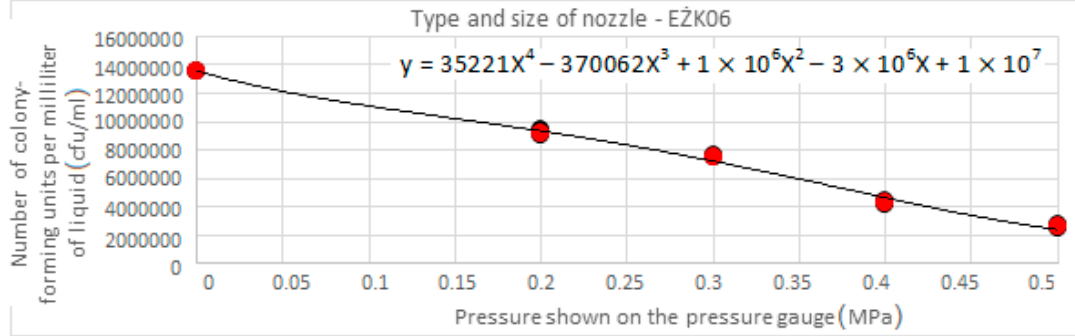
Figure 6. The influence of pressure on survival of cfu/mL of liquid for E Ż K05.